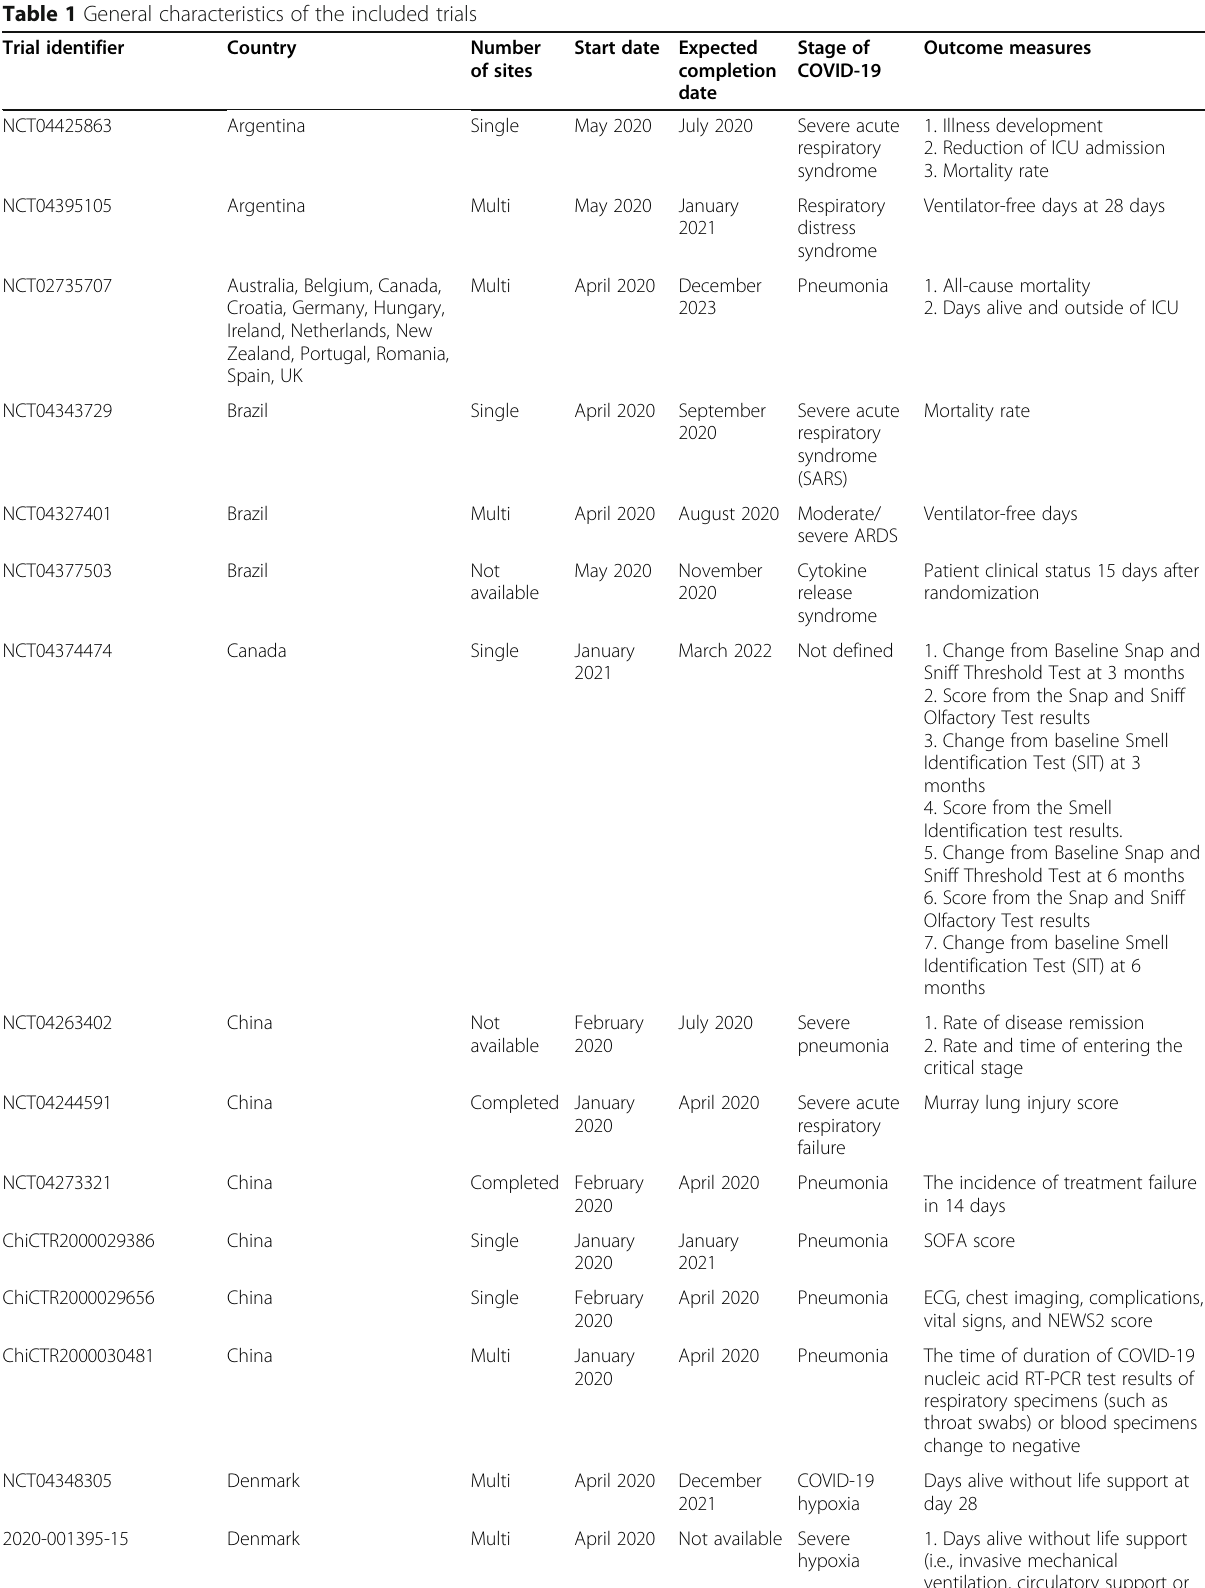
Table 1 General characteristics of the included